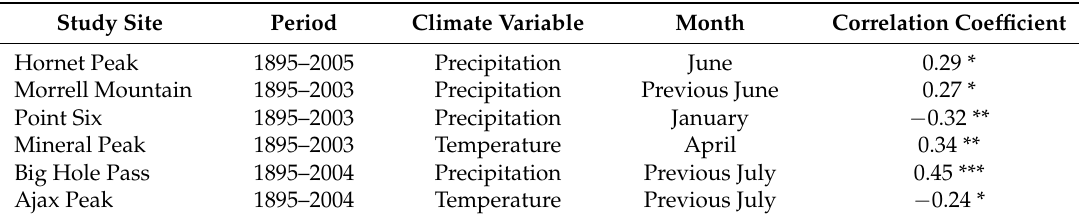
Table 3. Strongest relationships between whitebark pine radial growth and mean monthly temperature and total monthly precipitation in western